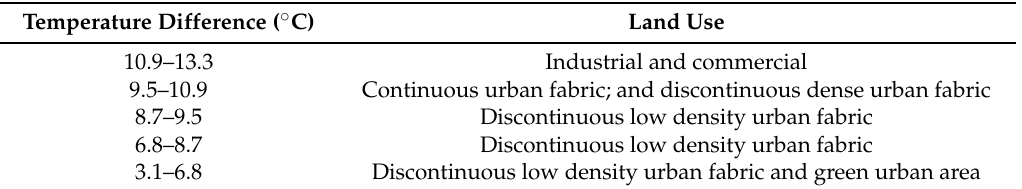
Figure 6. LST and T air daytime comparison at 13:30. ( a ) LST—T air difference (MODIS—BUCL); ( b ) R 2 values at sensors and weather stations location; ( c ) R 2 values for city scale (all sensors and weather stations). Table 5. Temperature difference (LST—T air ) at 13:30 and Land use [37].